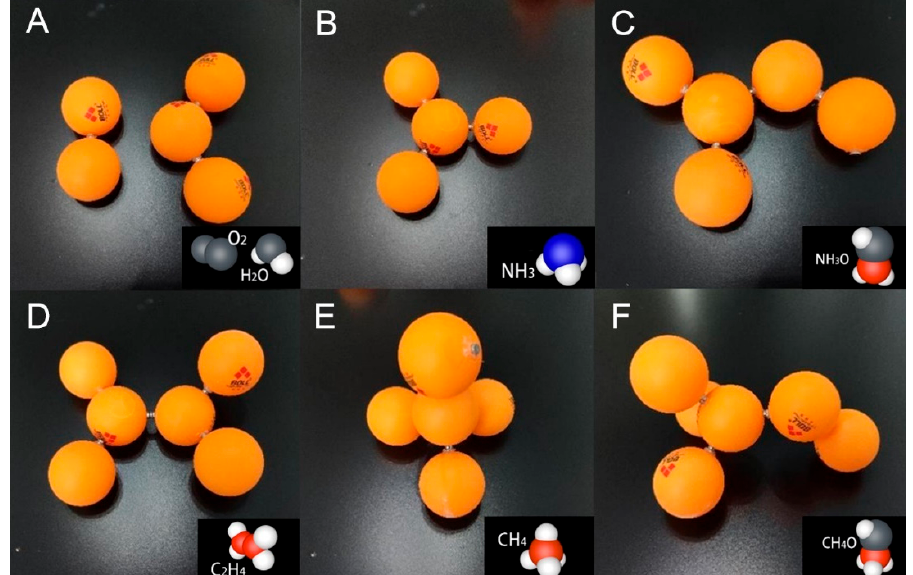
Figure 5. The stable connected structure results. ( A ) The water (H 2 O)-like structure result and the hydrogen (H 2 )/oxygen (O 2 )-like structure result. ( B ) Ammonia (NH 3 )-like structure result. ( C ) The hydroxylamine (NH 2 OH)-like structure result. ( D ) Ethylene (CH 2 CH 2 )-like structure result. ( E ) Methane (CH 4 )-like structure result. ( F ) Methanol (CH 3 OH)-like structure result.